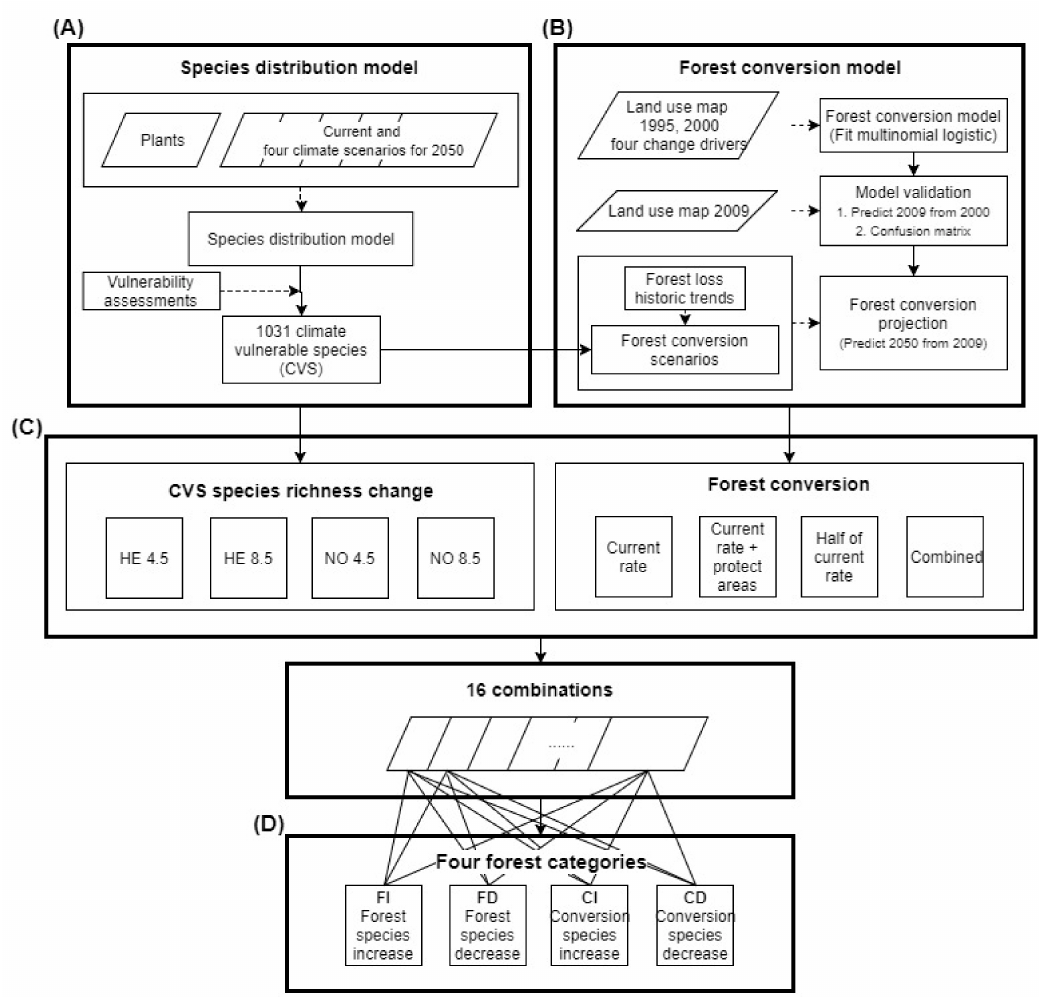
Figure 1. Study flow. ( A ) We estimated the change in species richness in existing forest areas using the modeled ranges of 1031 climate vulnerable plant species under four climate scenarios for